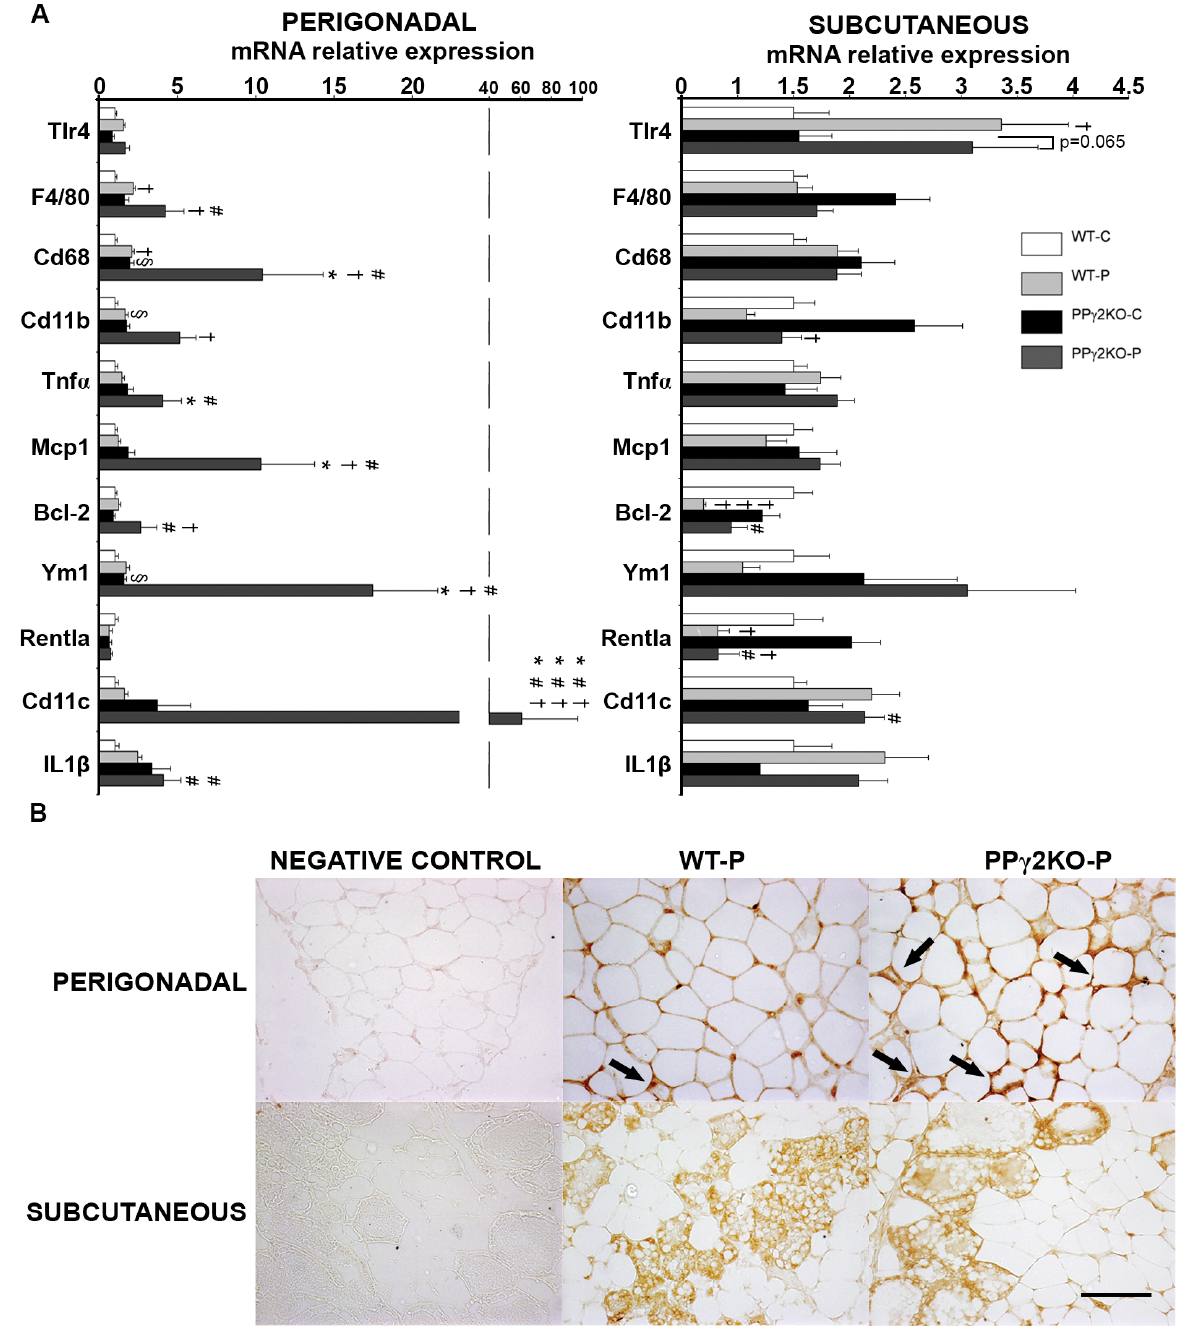
Figure 4. Increased inflammation in perigonadal but not subcutaneous WAT in pregnant mice lacking PPAR γ 2. (A) mRNA levels of rep- resentative inflammatory genes in perigonadal and subcutaneous fat depots from pregnant and nonpregnant WT and PP γ 2KO mice. Data are expressed as mean ± SEM (n = 6–8 animals/group). † p ≤ .05; ††† p ≤ .001 pregnant versus nonpregnant; # p ≤ .05 ### p ≤ .001 PP γ 2KO-P versus WT-C; * p ≤ .05 *** p ≤ .001 PP γ 2KO-P versus WT-P; § p ≤ .05 PP γ 2KO-C versus WT-C. (B) Immunohistochemical analysis of MCP-1 expression in paraffin-embedded perigonadal and subcutaneous fat depots from pregnant WT and PP γ 2KO groups (n = 4 ani- mals/group). No immunoreaction was observed in the negative control treated with PBS without primary antibody. Arrows indicate the locations of infiltrated macrophages, which form crown-like structures surrounding dead and dying adipocytes, which express MCP-1. Original magnification × 200. Scale bar: 100 μ